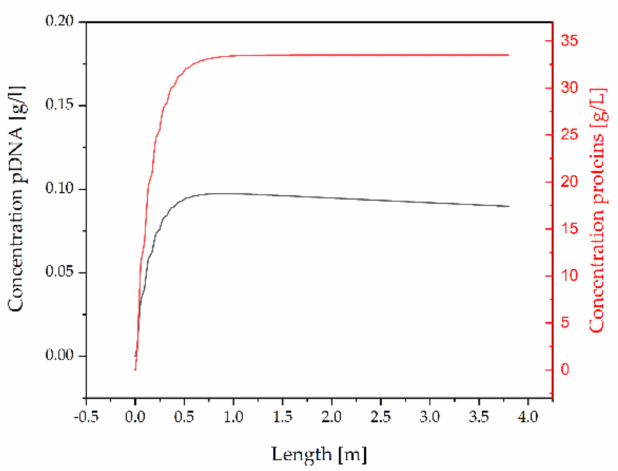
Figure 8. Concentration profile of sc-pDNA and protein impurities during alkaline lysis. Lysis of E. coli cells is completed shortly after the lysis pathway is entered. A too-long residence time leads to the degradation of the desired isoform to undesired